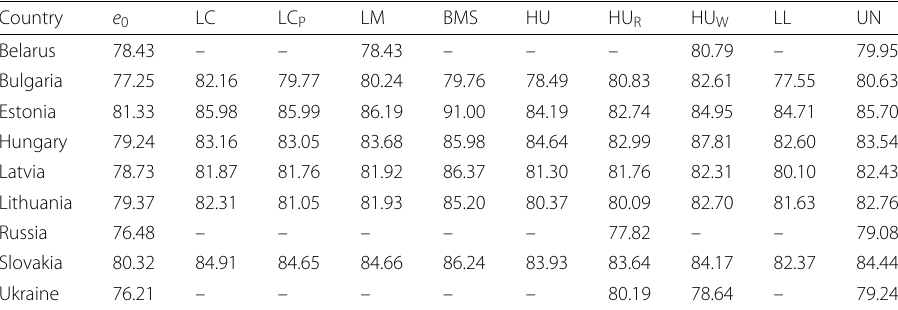
Table 2 Comparison of 40 years ahead life expectancy forecast for selected countries with high mortality